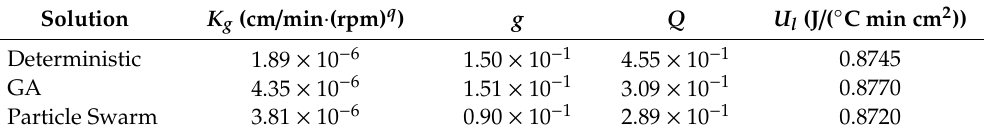
Table 7. Kinetic parameters of crystals growth rate and global coe ffi cient of thermal change.